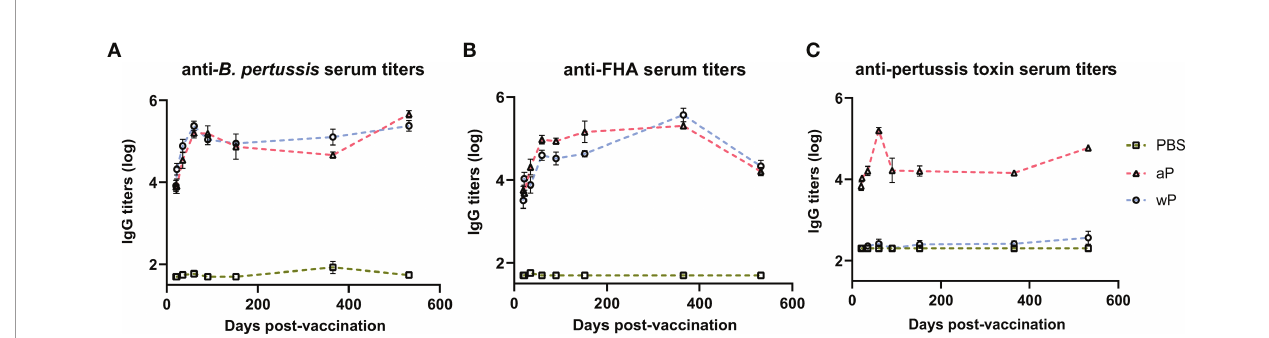
FIGURE 2 | Pertussis speci fi c antibody responses peak after boost and persist over time in immunized CD1 mice. Measured in serum of non-challenged mice collected at day 20, day 22, day 35, day 60, day 90, day 152, day 365, and day 532 post-vaccination. (A) IgG anti- B. pertussis antibodies in vaccinated mice (B) IgG anti-FHA antibodies in vaccinated mice (C) IgG anti-PT antibodies in vaccinated mice. Antibody responses were at or below the limit of detection in PBS vaccinated mice. To note, there is a lack of PT in the NIBSC wP formulation due to manufacturing practices. Days 20 and 22 were from three independent experiments (n=12). Day 35 is from four independent experiments (n=16). Days 60 and 90 were from two independent experiments (n=8). Days 152 (n=4), 365 (n=8), and 532 (n=4) are from one independent experiment. Data were log10-transformed. Statistical analysis and p values are shown in Table S1